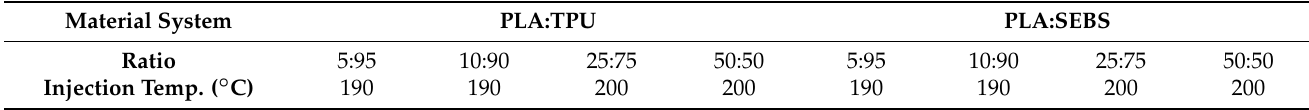
Table 2. Injection molding temperatures for the blends used in this study 1 .